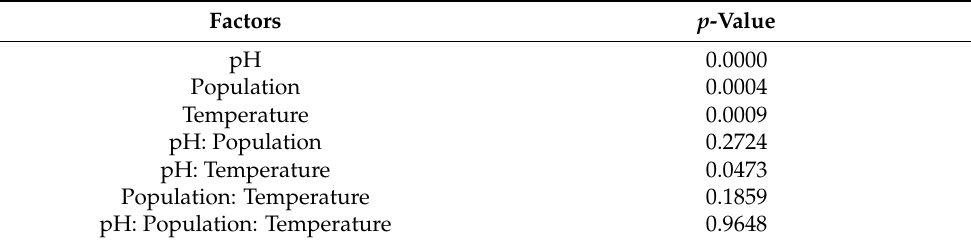
Table 2. The effects of pH, population, and temperature and their interactions on the final germination of D. stramonium .